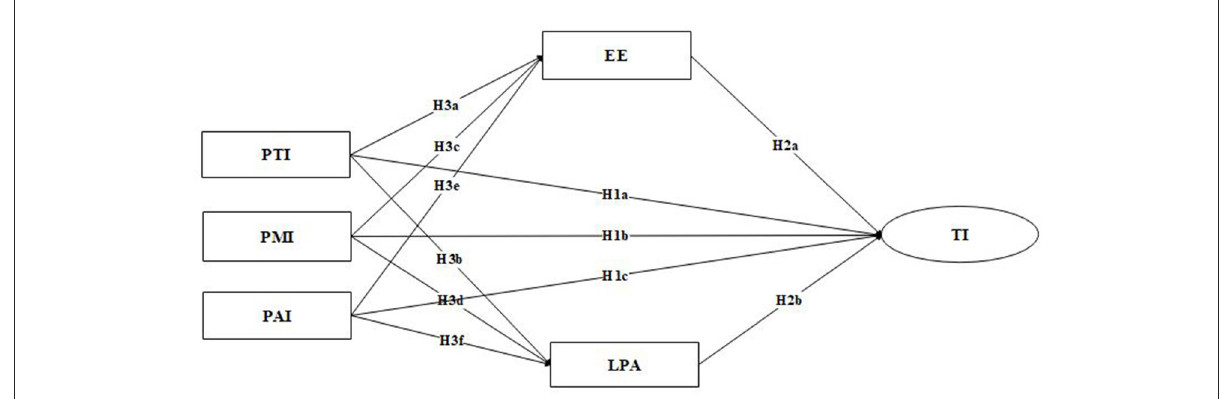
FIGURE1 Theoretical model. PTI, professional treatment identity; PMI, professional meaning identity; PAI, professional ability identity; EE, emotional exhaustion; LPA, low personal achievement; TI, turnover intent.